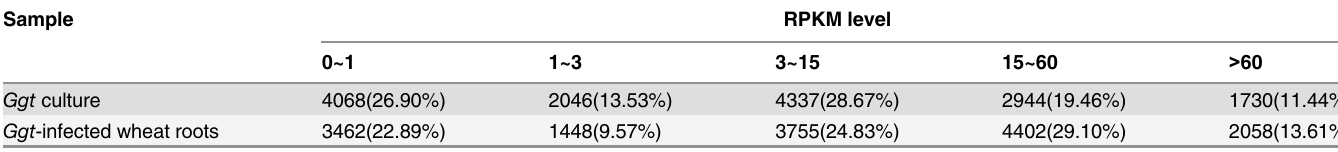
Table 3. Number of transcripts of Ggt culture and Ggt -infected wheat roots at different expression level intervals. Sample